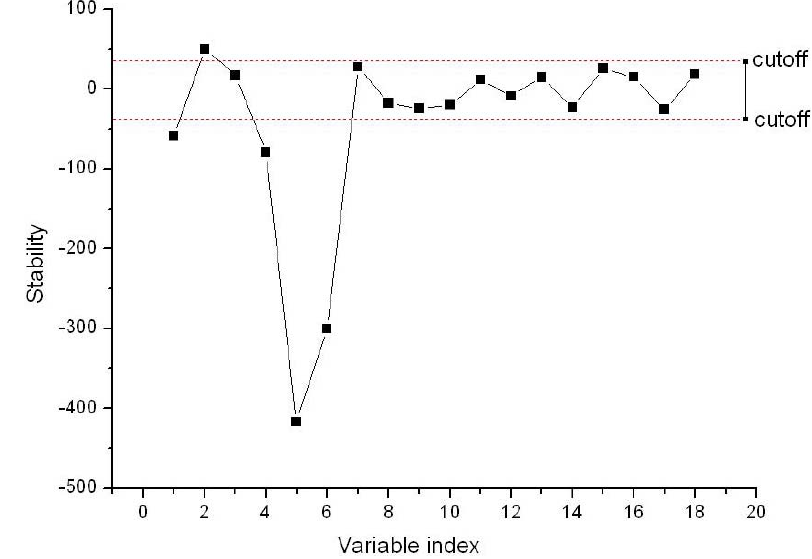
Figure 7. Stability distribution of each variable, and the two red dotted lines indicate the lower and upper cutoff.